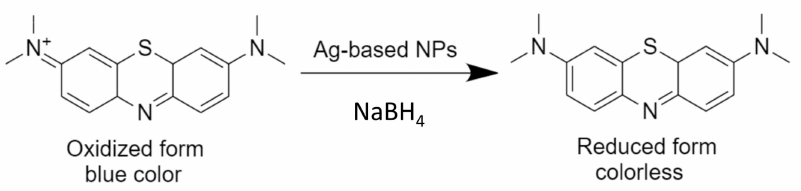
Figure 9. Schematic of reduction reaction of MB dye using NaBH 4 in the presence of our sustainable Ag-based NPs catalyst.